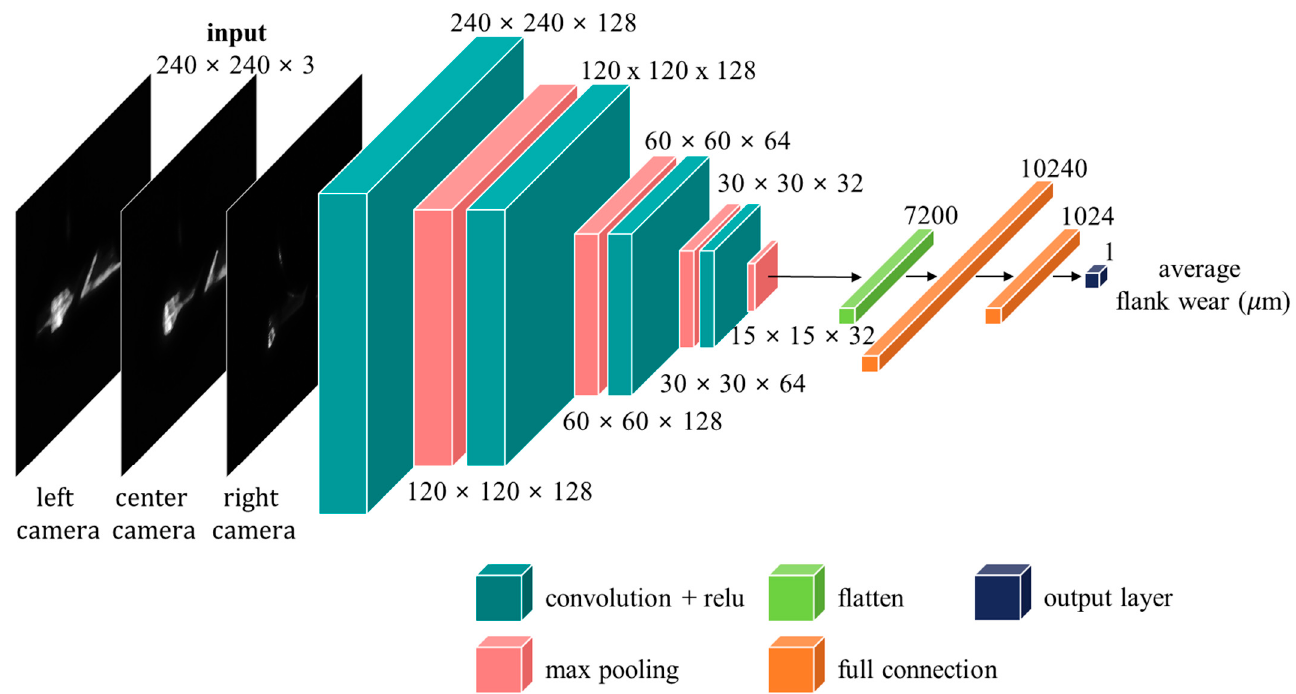
Figure 10. Deep-learning architecture for tool wear estimation.